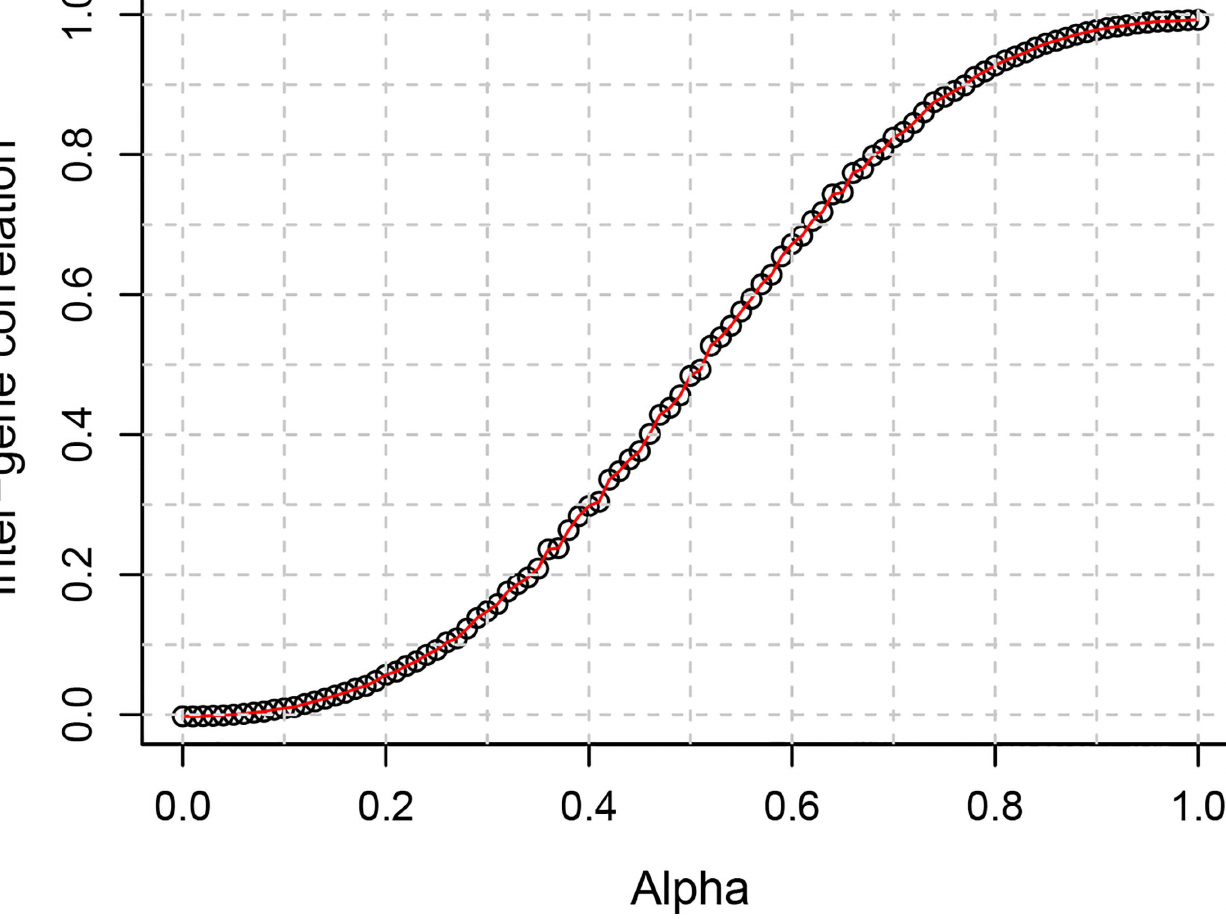
Fig 1. The relationship between the mixing coefficient (alpha) and the averageinter-gene